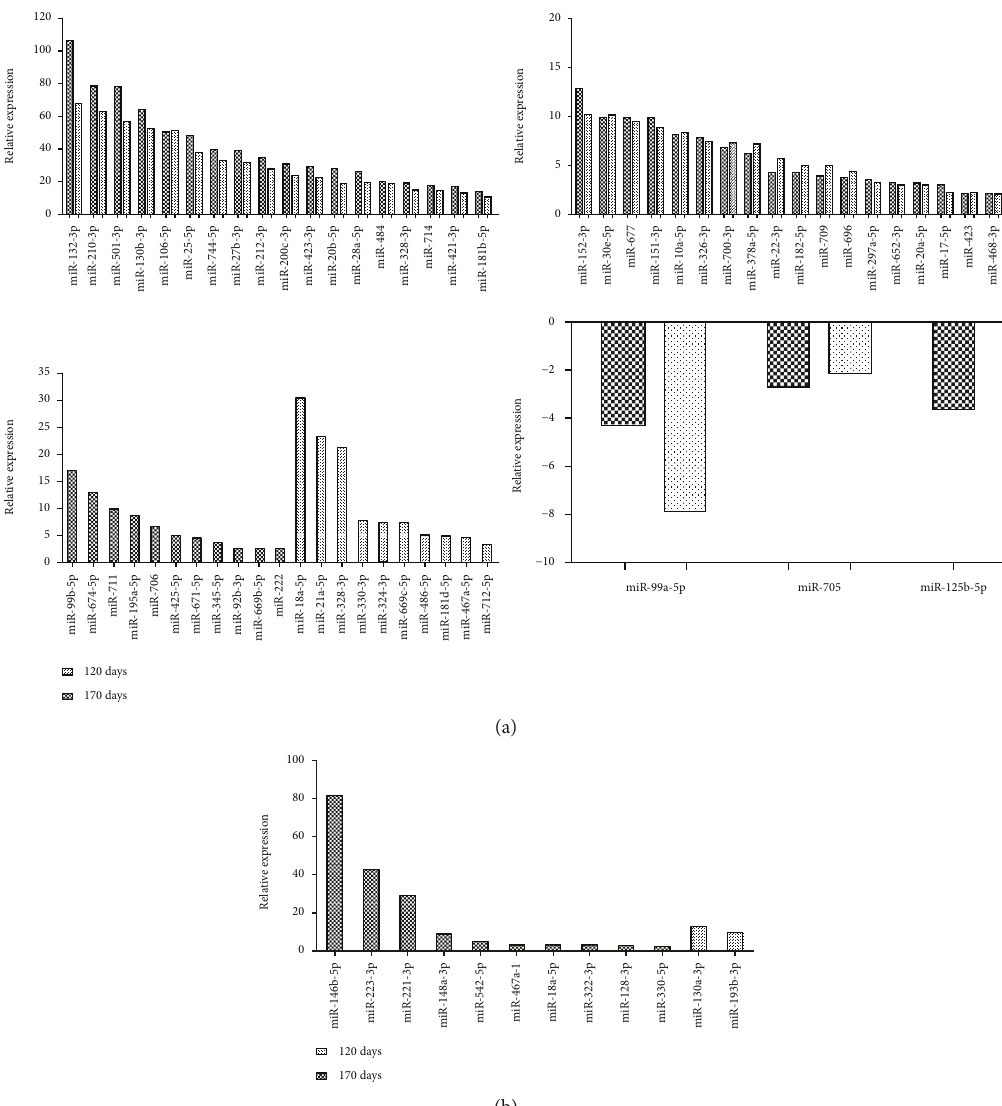
Figure 4: (a) Up- and downregulated miRNAs after pristane injection. Only the miRNAs predicted to interact with their targets in at least 3 di ff erent databases were shown. (a) miRNAs exclusively modulated in AIRmax mice and (b) miRNAs exclusively modulated in AIRmin mice. Di ff erentially expressed miRNAs (miRDEGs) were detected using unpaired one-way ANOVA, with FDR < 0 05 and considering a minimum 2-fold di ff erence for